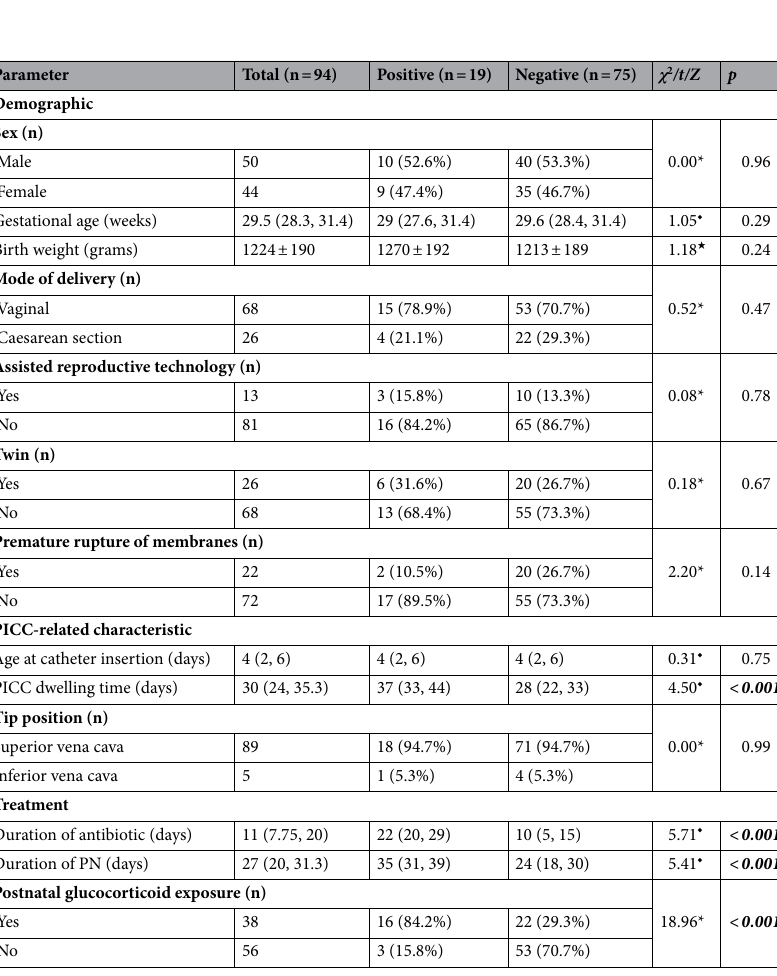
Table 2. Univariate analysis of fungal colonization at the catheter tips. *Chi-square test, ★ t test, and ◆ rank-sum test. PICC peripherally inserted central catheter, PN parenteral